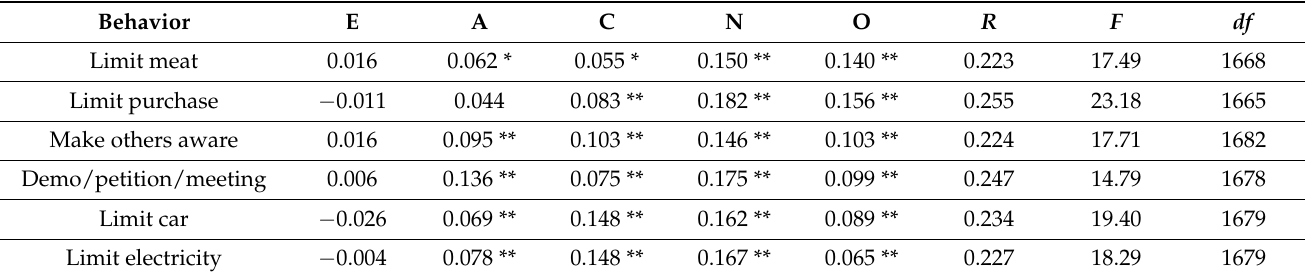
Table 5. Relationships between personality and perceived effectiveness of climate change mitigation